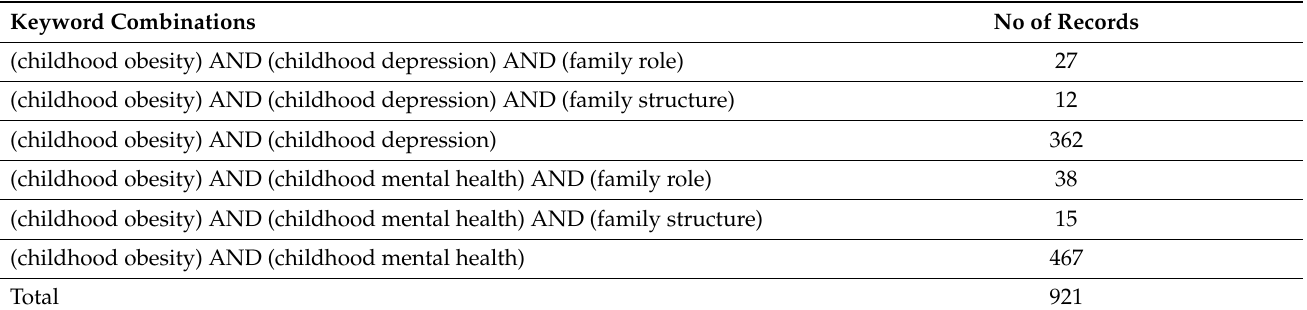
Table 1. Number of records retrieved per keyword